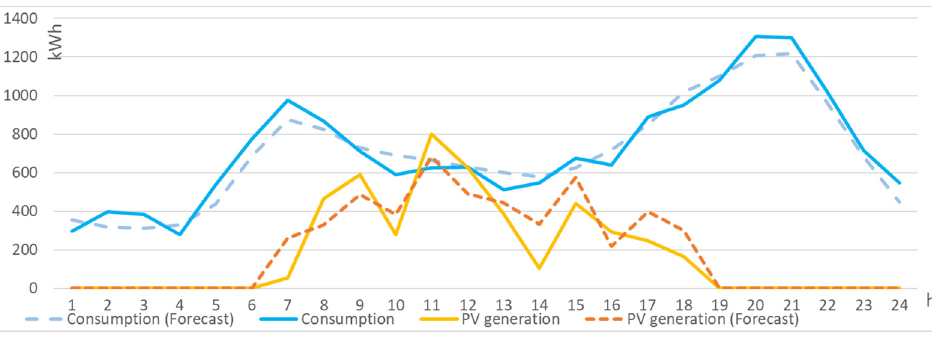
Figure 6. The consumption and PV generation, summer cloudy day (real and forecasted case). The analyses of error between the forecasted and real data are presented in Table 2, using MAPE and MAE. Table 2. The mean absolute percentage error (MAPE) and mean absolute error (MAE) of forecasting data.